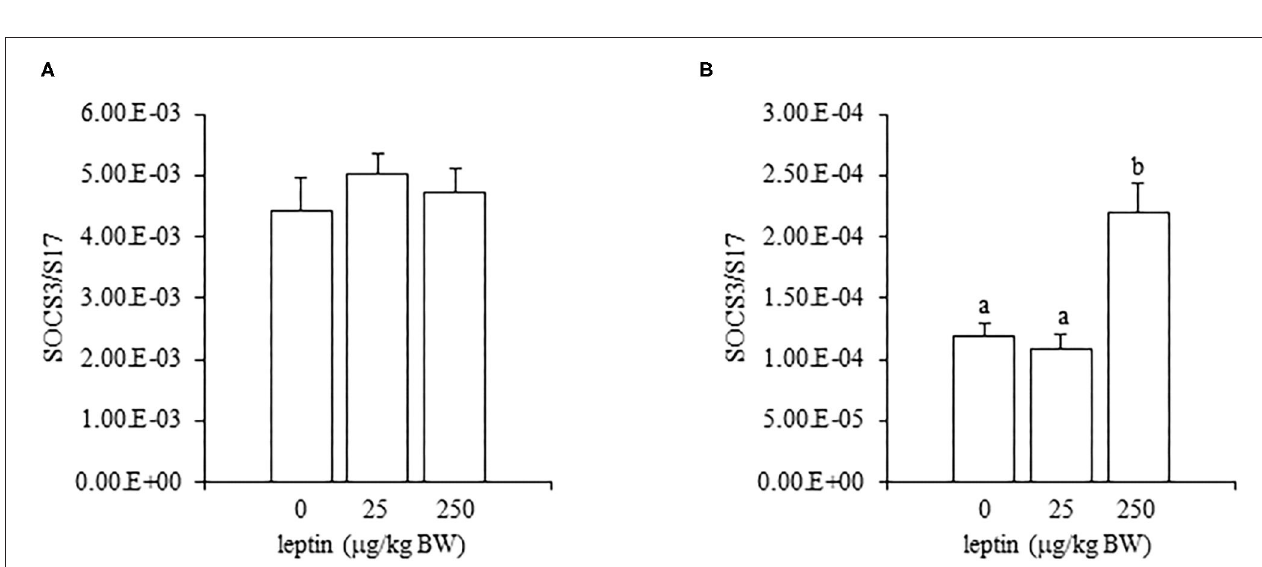
FIGURE 7 | The mRNA expression of LHB (A) and FSHB (B) at 24h after leptin treatment in the pituitary gland in the 28-day-old chicks. Chicks were injected i.p. with 0, 25, and 250 µ g/kg BW of rmleptin. The data represent the mean ± SEM ( n = 6). Each raw data are shown as a dot.